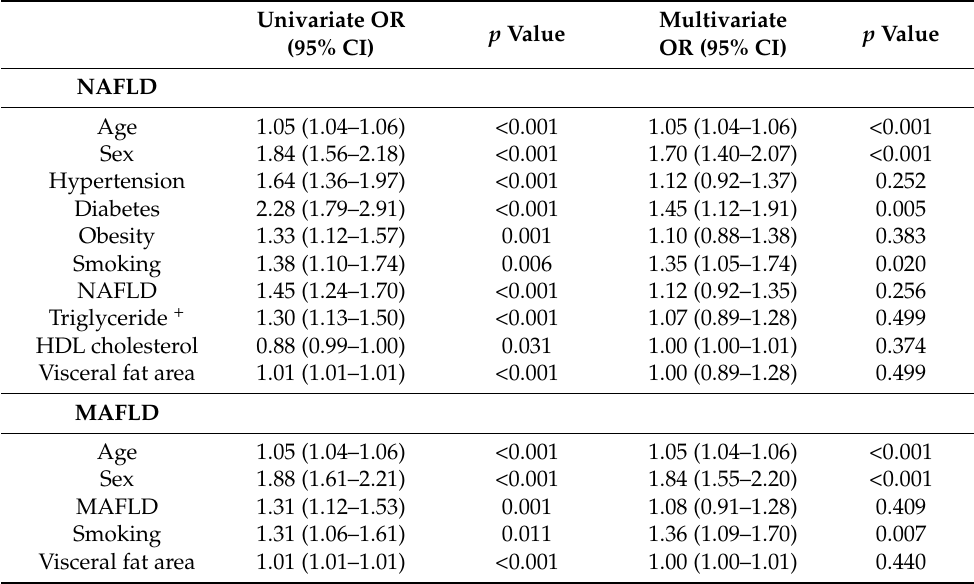
Table 2. Univariate and multivariate analyses of the risk for colorectal adenoma.